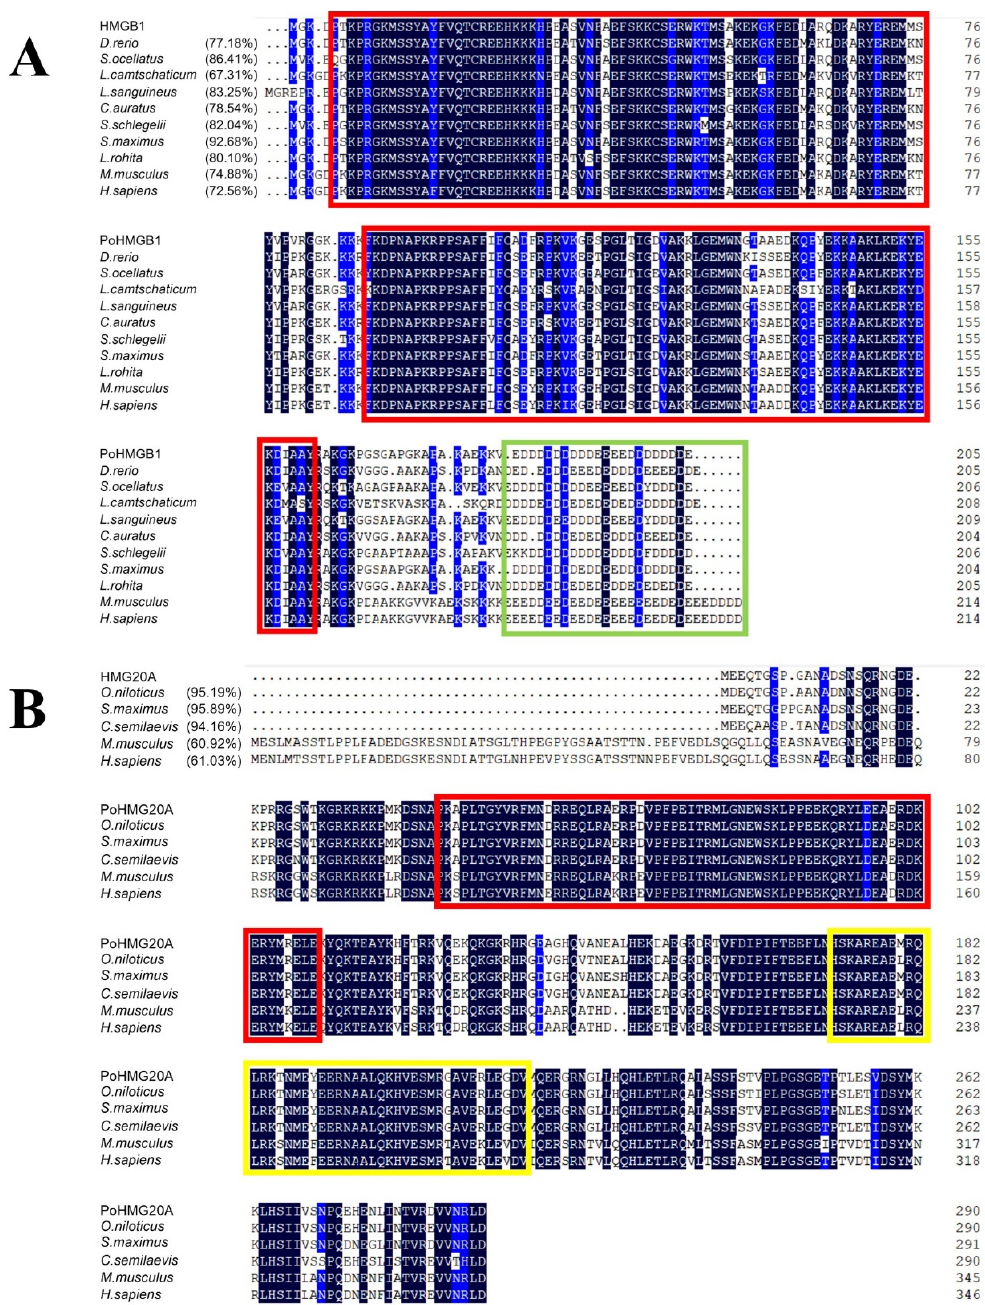
Figure 1. Alignment of the protein sequences of HMGB1 and HMG20A homologues. Flounder HMGB1 ( A ) and HMG20A ( B ) were aligned with homologues from other species. Overall protein sequence identities are indicated on the left of sequences. The identical residues are indicated in black; the residues that are ≥ 75% identical are indicated in blue; the red boxes indicate the HMG domains; the green box in ( A ) indicates the acidic tail; and the yellow box in ( B ) indicates the coiled coil region. HMGB1 GenBank accession numbers are as follows: Paralichthys olivaceus , AGT28457.1; Danio rerio , NP_955849.2; Sciaenops ocellatus , ADX06860.1; Lethenteron camtschaticum , AEH59759.1;